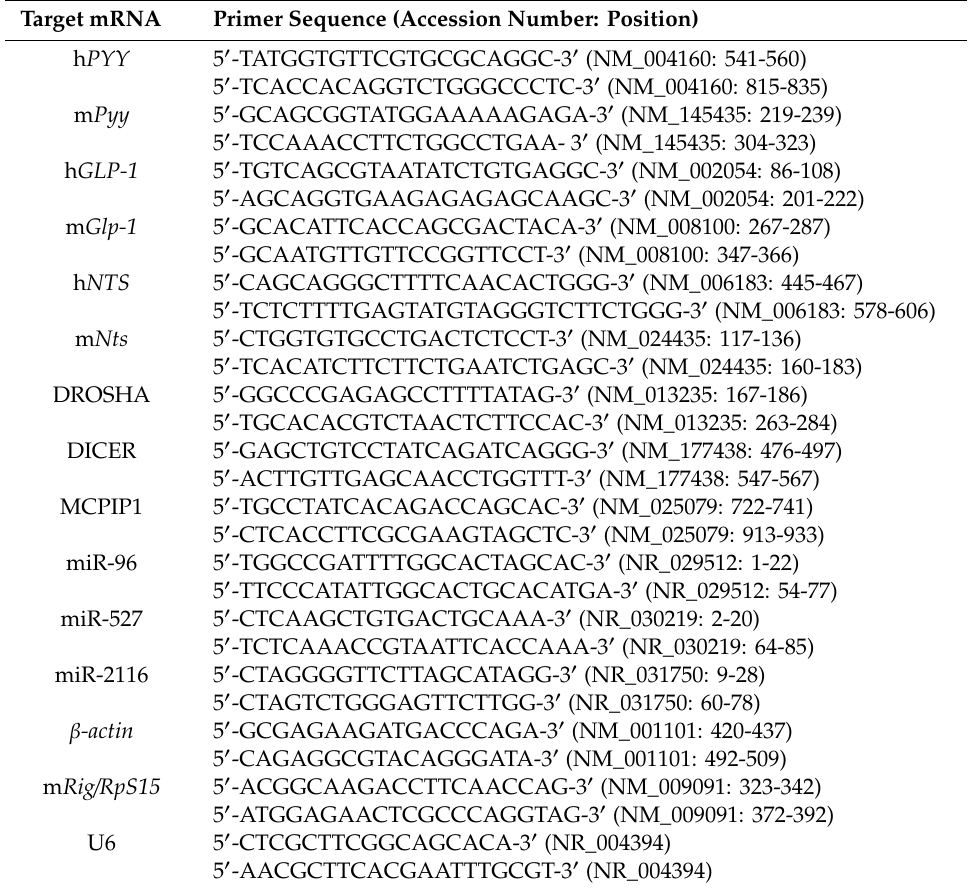
Table 1. PCR primers for real-time